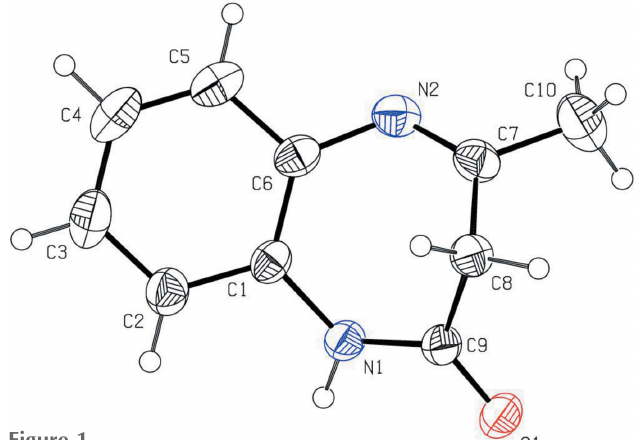
Figure 1 Molecular structure of the title compound with displacement ellipsoids drawn at the 30% probability level.